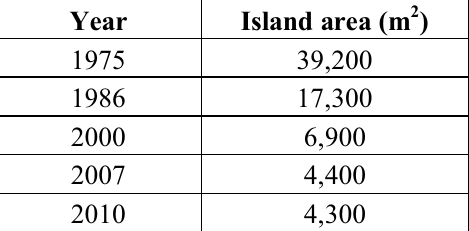
Table 3. Kwelekwele island mangrove area change 1975 to